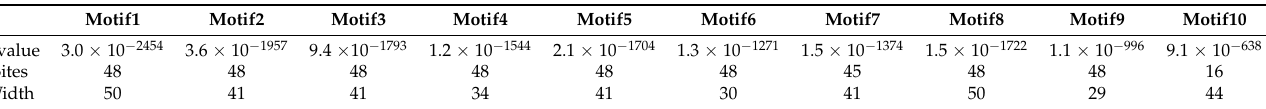
Figure 6. The phylogenetic relationships, motif patterns and conserved domains of Smads 1 , 4 , and 5 in 15 mammalian species. ( A ) Phylogenetic relationships; ( B ) motif pattern; ( C ) conserved domains. Ten conserved motifs and five kinds of conserved domains in Smads 1 , 4 , and 5 are labelled with different color boxes. Table 3. E-value, sites, and widths of Smad1/4/5 conserved